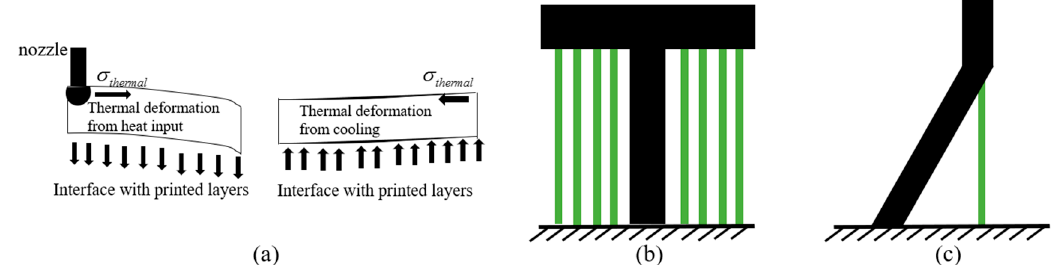
Figure 3. ( a ) stress gradients in single layers; left is the heating state of stress; right is the cooling state of stress; ( b ) an example of a support structure for printability; ( c ) an example of a support structure for part balance. (The black structures are the parts while the green struts are the support structures).